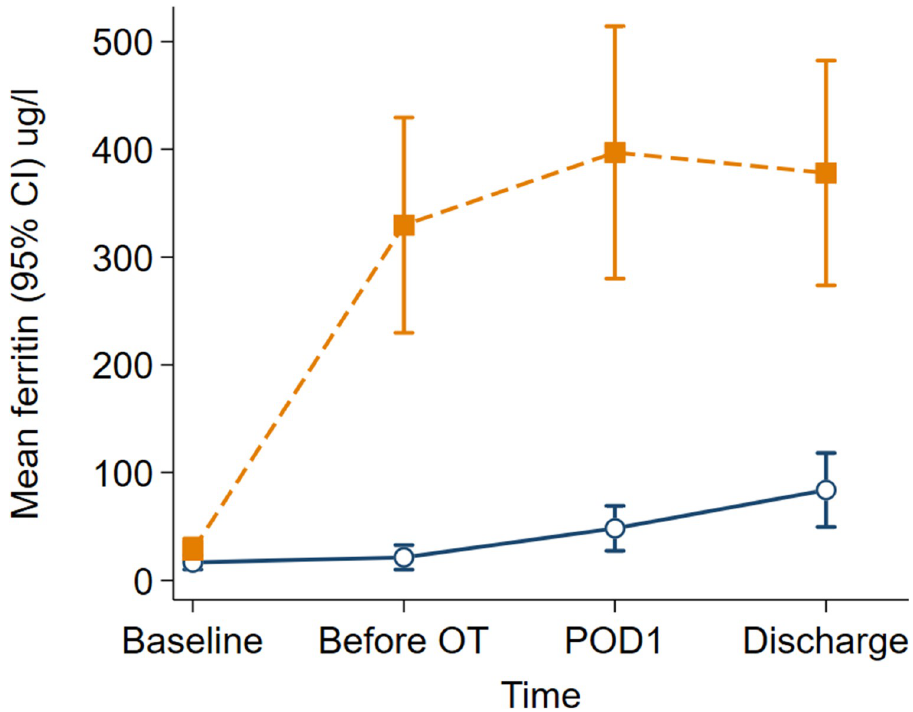
Fig 3. Ferritin concentrations ( μ g. -1 ) over time by treatment groups. Data are mean with error bars showing the 95% confidence interval. Intravenous iron isomaltoside (filled orange squares with dash line); control (unfilled navy circles with solid line). OT, operating theatre; POD1, postoperative day